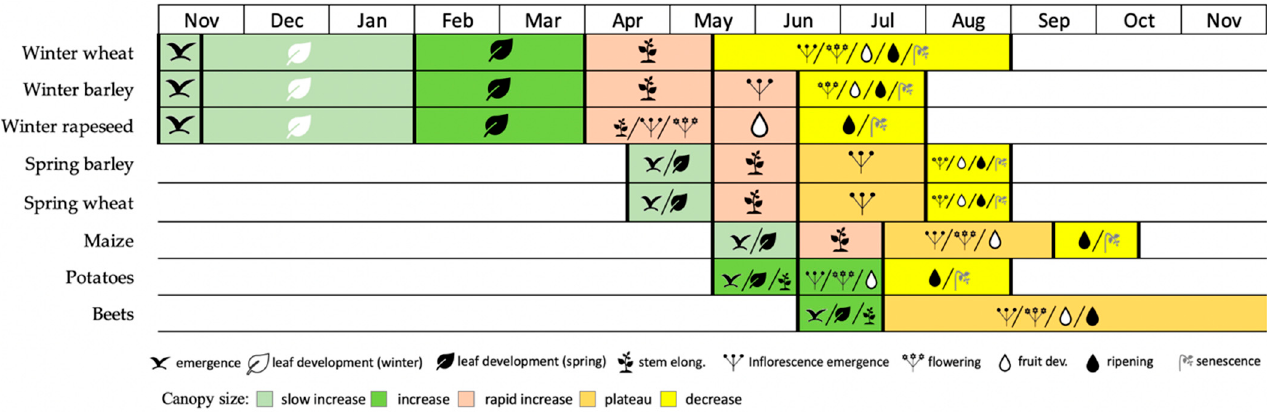
Figure 2. Key knowledge-based growth stages of the eight crop types with associated theoretical periods in Wales and indications of changes in canopy size. Note: canopy size = any change in green biomass, green leaf area index (GLAI), canopy cover, or